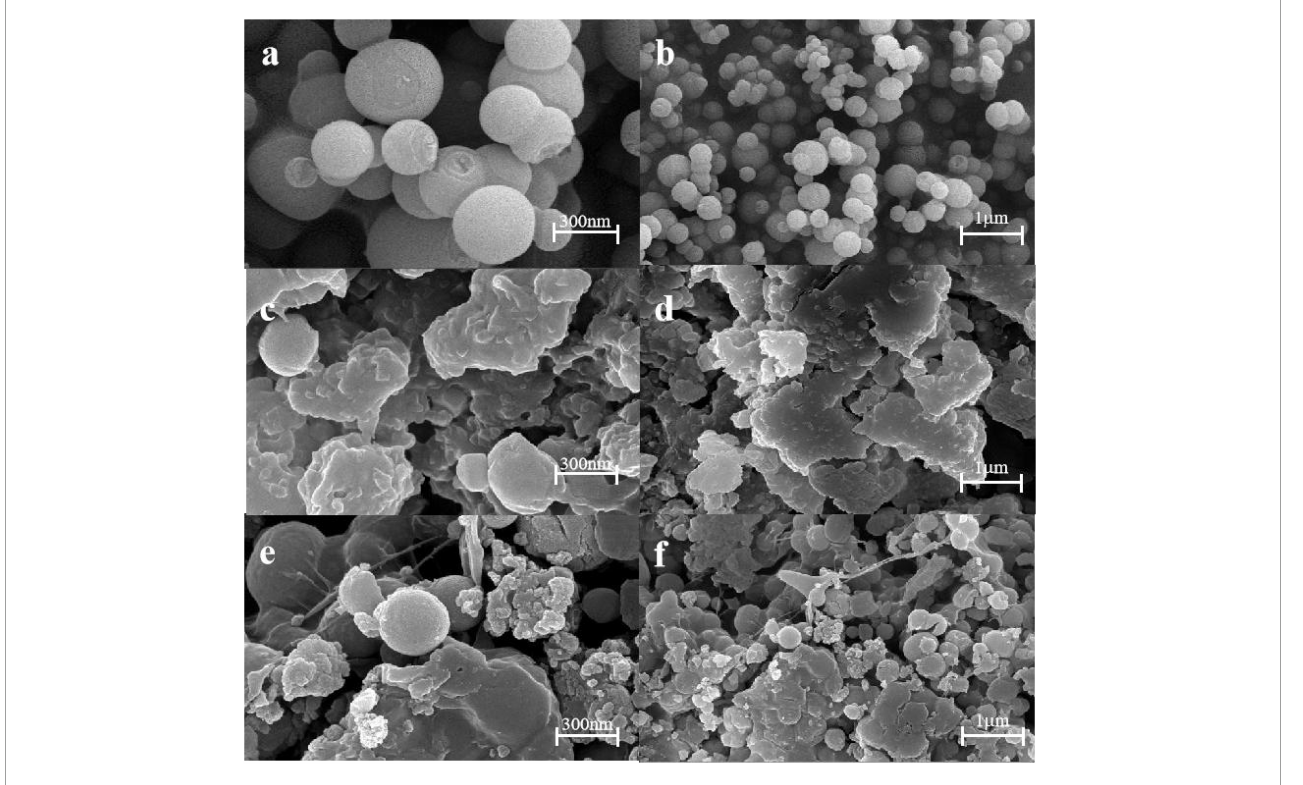
FIGURE4 Scanning electron microscope (SEM) images of MSN (a,b) , KS (c,d) , and KS/MSN (e,f) .